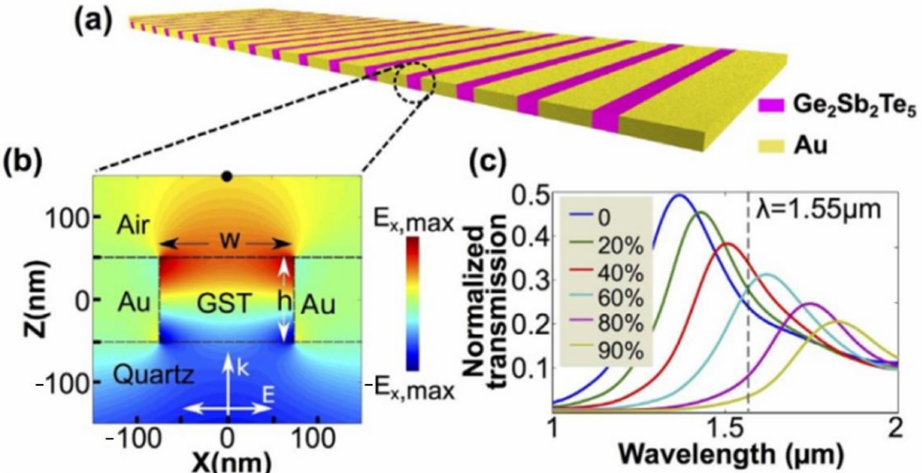
Figure 11. ( a ) Continuous metasurface with a 1D array of nanoslits filled with G 2 S 2 T 5 ; ( b ) the schematic of F–P mode between the Au nanoslit intervals; ( c ) a varied crystallization level leading to a series of evolved transmission spectrum, enabling the multistate tuning of focusing—all figures are produced with permissions from